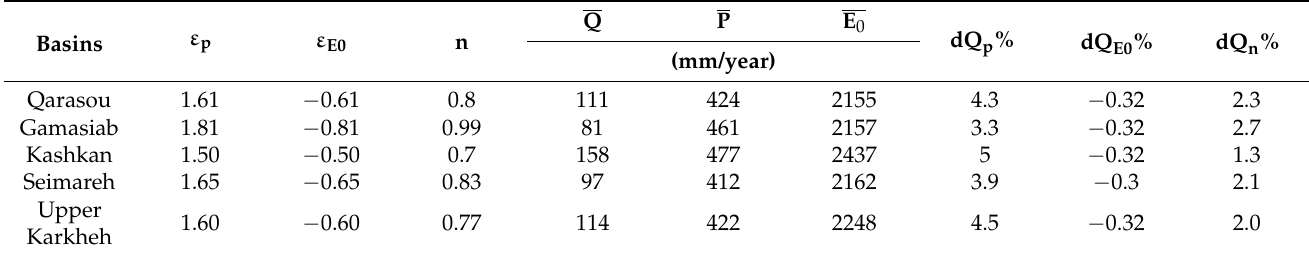
Table 10. Streamflow response to a 10% change in the Budyko input